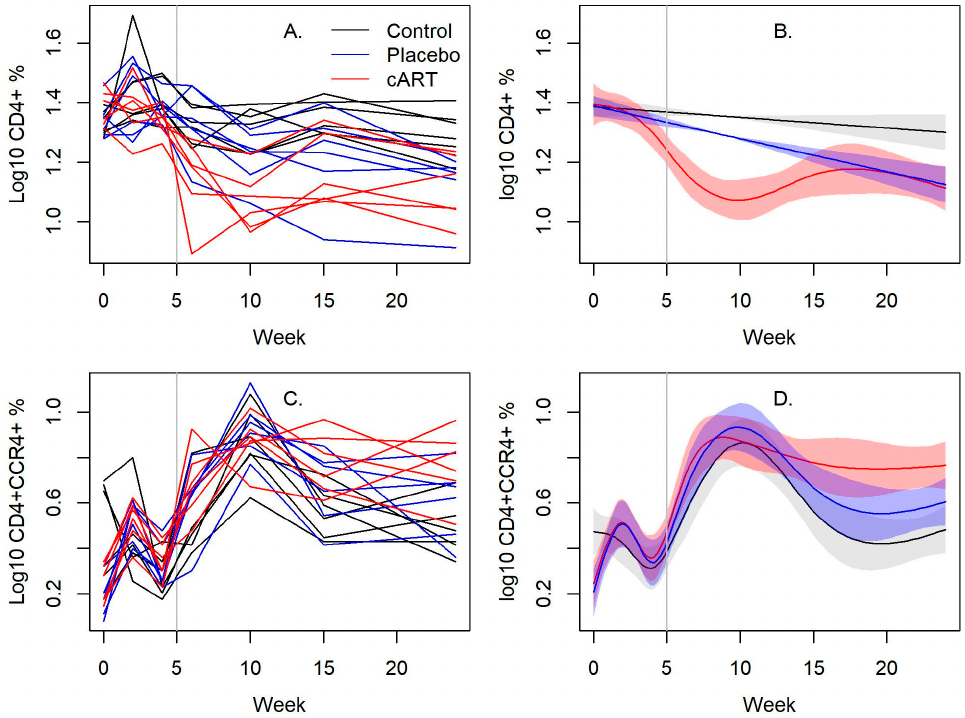
Figure 4. FIV infection induces a primary Th2 immunophenotype. cART significantly lowered CD4 + T cells in the blood of FIV+ cats compared to those treated with a placebo. CD4 + CCR4 + cells in cART- treated FIV+ cats were significantly higher than in placebo-treated FIV+ cats, and both were slightly higher than in uninfected control cats. cART may inhibit inflammation and immune activation of FIV infection with an upregulated Th2 immunophenotype. The vertical gray bar indicates when cART and placebo treatment began. ( A , C ) Line plots of individual cats over time and ( B , D ) their associated spline fits from GAM analyses are